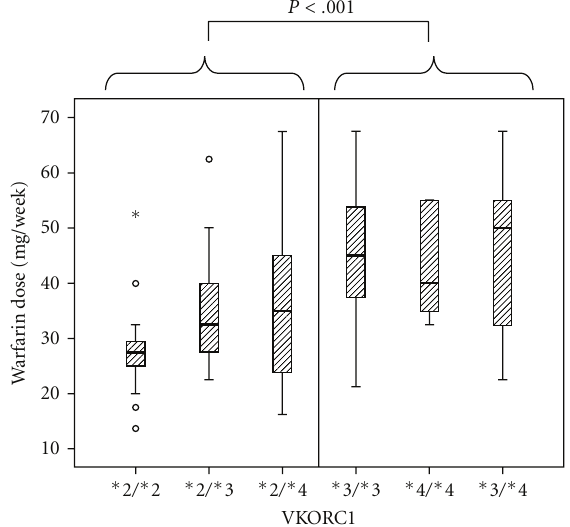
Figure 1: Box plot of mean weekly warfarin maintenance dose for combinations of di ff erent VKORC1 haplotypes. The boxes represent the values from the 25th to 75th percentile. The middle lines represent the median. The vertical lines extend from the minimum values to the maximam values, excluding outliers and extreme values marked with open circles and asterisk, respectively. The P -value indicates the statistical significance of the di ff erence in mean weekly warfarin dose between patients with or without the VKORC1 ∗ 2 haplotype (Mann-Whitney